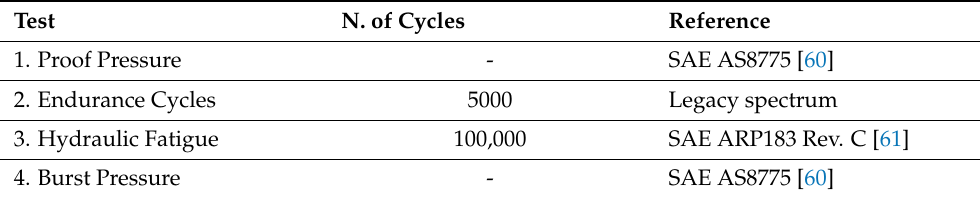
Table 7. Summary of qualification tests.